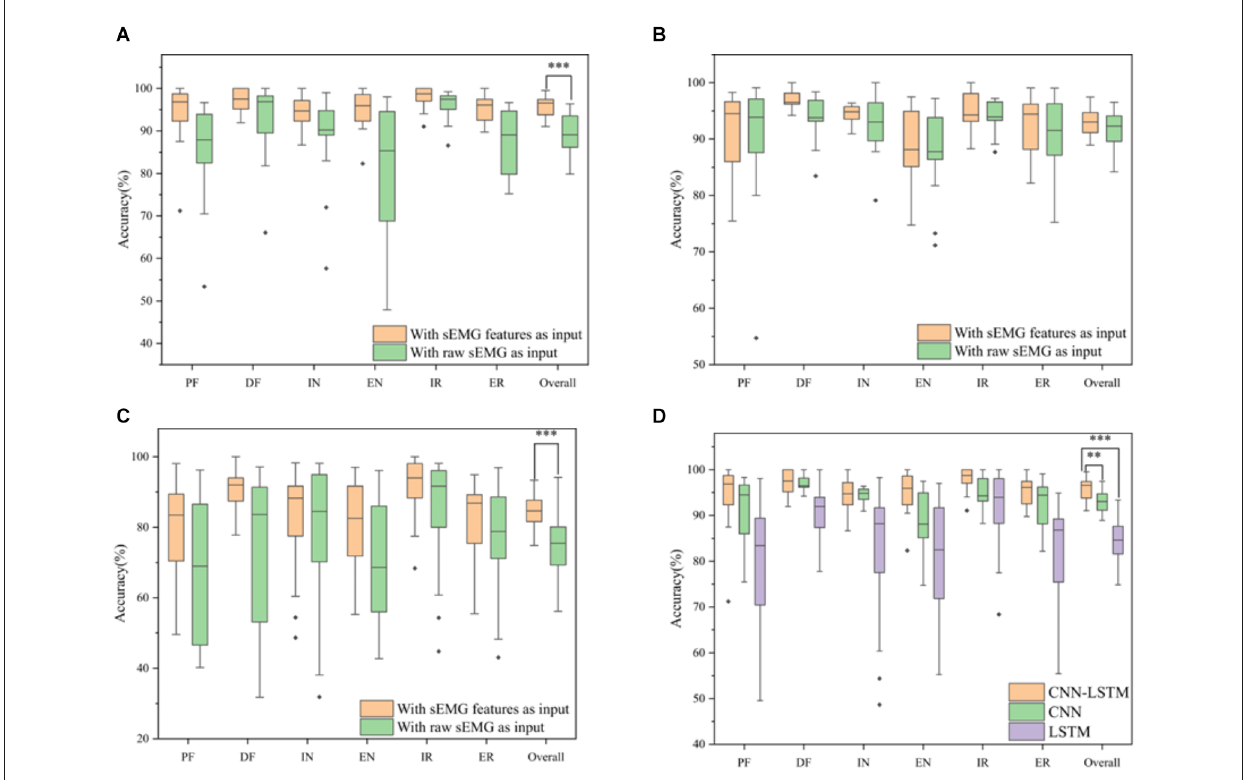
FIGURE10 Classification accuracy for six movements using different models. (A) CNN-LSTM model with sEMG features and raw sEMG as the inputs. (B) CNN model with sEMG features and raw sEMG as the inputs. (C) LSTM model with sEMG features and raw sEMG as the inputs. (D) Classification